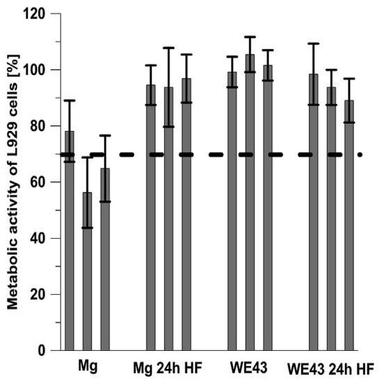
The relative metabolic activity of L929 cells exposed to extracts from Mg and WE43 alloy (cells treated with sole MEMþ5% FBS used as a negative control had 100% metabolic activity). The line stands for normative cut-off for cytotoxicity. Error bars represent SSD from hexaplicates.